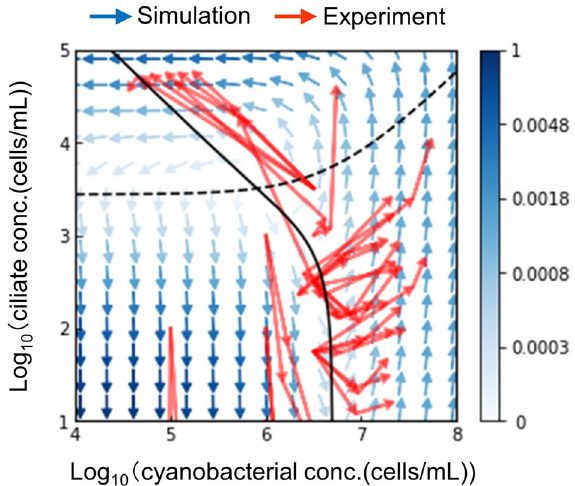
Figure 3. Direction field of the population dynamics of coculture. The red and blue arrows represent the values obtained from the experimental results and mathematical model, respectively. In each red arrow, the starting point indicates the initial cell concentration of both species in a coculture, while the ending point of the arrow indicates the cell concentration after 3.5 d. In each blue arrow, the angle shows the direction of change in the log-scale, as the vector of ( dC S / dt )/ C S and ( dC T / dt )/ C T from Eq. (1). The color of the blue arrows shows the magnitude of the vector in logarithm. The values of the model constants were obtained by fitting of the model to the experimental results, using the quasi-Newton method: specifically, the values of k S , d S , k T , d T , K M , and K I were 0.285 d –1 , 5.16 × 10 2 d –1 , 3.20 d –1 , 1.50 × 10 3 d –1 , 4.99 × 10 6 cells/mL, and 1.86 × 10 –4 , respectively. The black solid and dashed lines represent nullclines of population of the ciliate ( C T = d T ( C S + K M )/ k T C S − K I C S ) and cyanobacterium ( C T = k S ( C S + K M )/ d S ), respectively. For example, the black solid line denotes the boundary between increase or decrease of the ciliate population; the ciliate population increases (decreases) when the state is to the right (left) of the line. Similarly, the black dashed line denotes the boundary between increase or decrease of the cyanobacterial population; the cyanobacterial population increases (decreases) when the state is below (above) of the